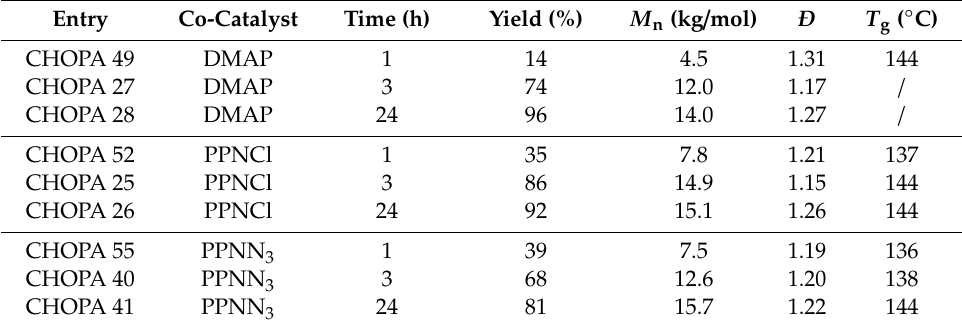
Table 4. CHO / PA copolymerization catalyzed by complex 3 and di ff erent co-catalysts a .